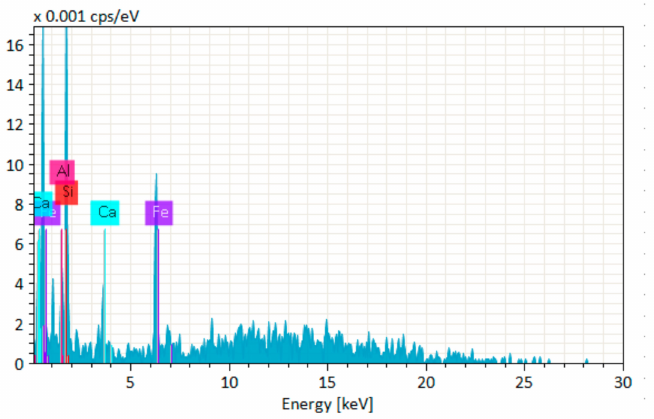
Figure 24. EDS graph of GPC-E0F mix specimen.